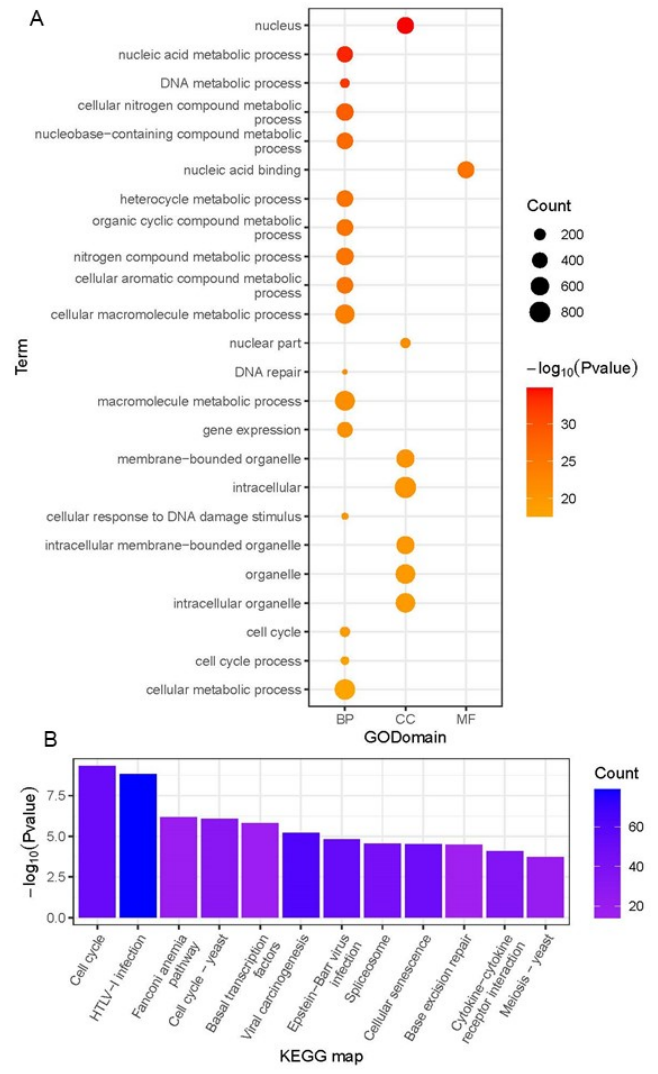
Figure 3. Functional enrichment results of PC1-related genes in all samples. ( A ) GO enrichment results (top 24); ( B ) KEGG enrichment results (top 12).